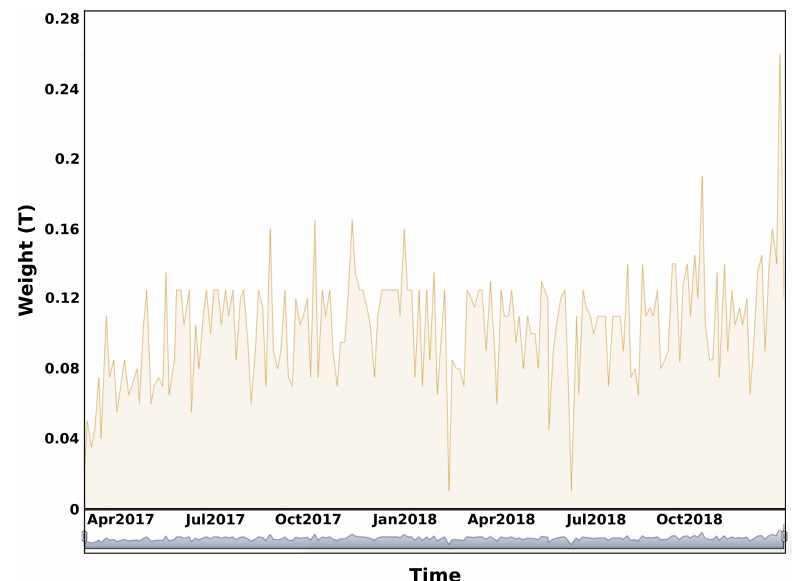
Figure 12. Example of the collected weight time-series extracted for a selected retail